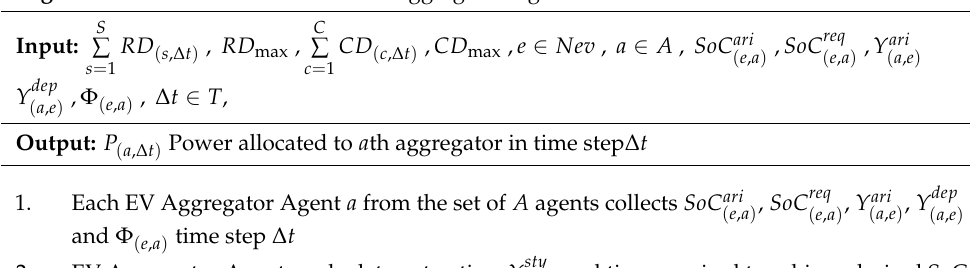
Algorithm 1. Power Allocation to EV Aggregator